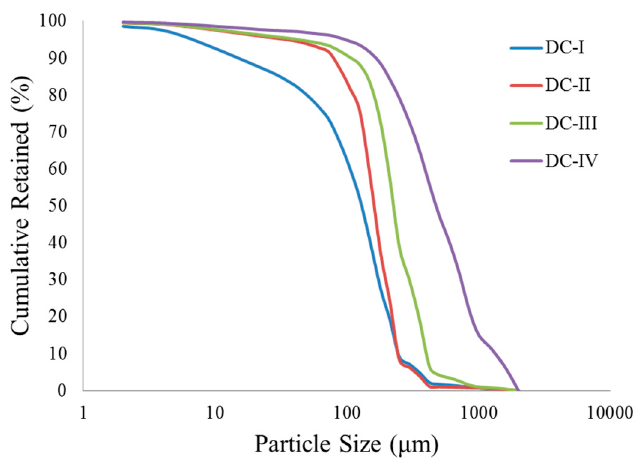
Figure 5. Particle size distribution (PSD) classes of McMurray formation oil sands (modified from Abram and Cain [38]).